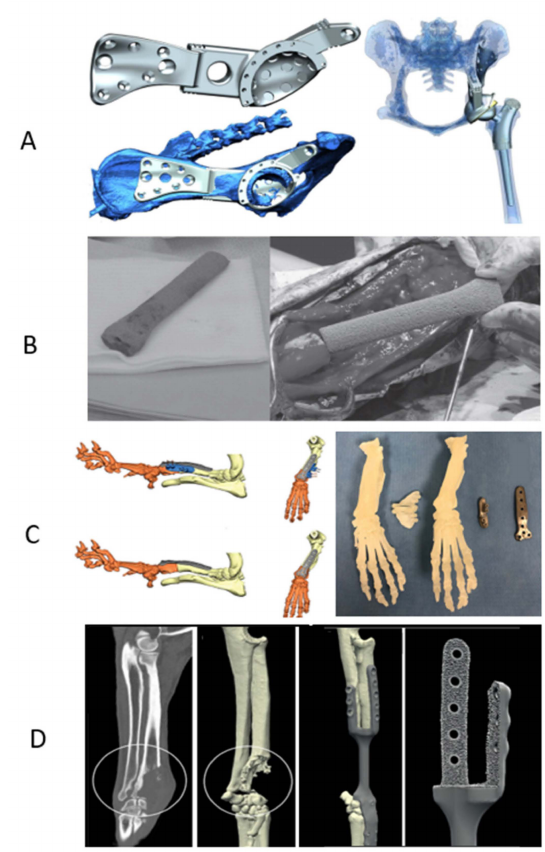
Figure 5. Custom-designed hemipelvic and proximal femoral endoprosthesis for limb salvage technique in a dog ( A ), custom-made tantalum distal radial endoprosthesis for limb sparing surgery in a dog ( B ), virtual planning ( C , left ) and custom-made 3D printed SLA models, osteotomy guide, reduction guide, and titanium plate ( C , right ) for correction of antebrachial limb deformity in a dog. ( D ) custom-made titanium implant for limb sparing surgery in a dog with distal radial OSA. Copy right 2022, ( A ) BLACKWELLPUBLISHING, INC., ( B ) Canadian Veterinary Medical